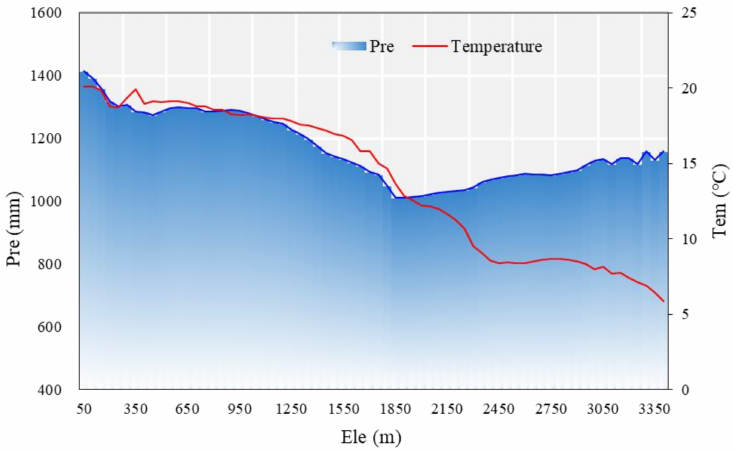
Figure 8. Average annual Tem and total Pre at different